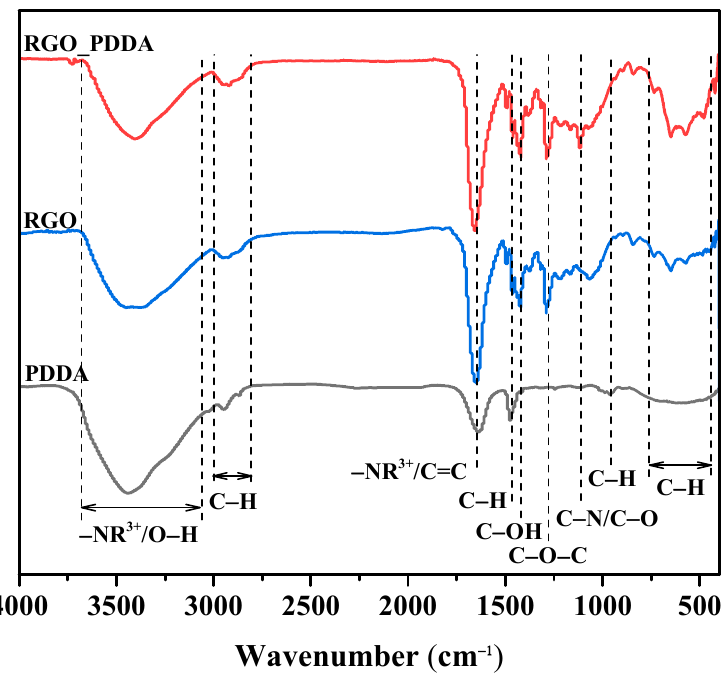
Figure 2. FTIR spectra of the RGO_PDDA, RGO, and PDDA.